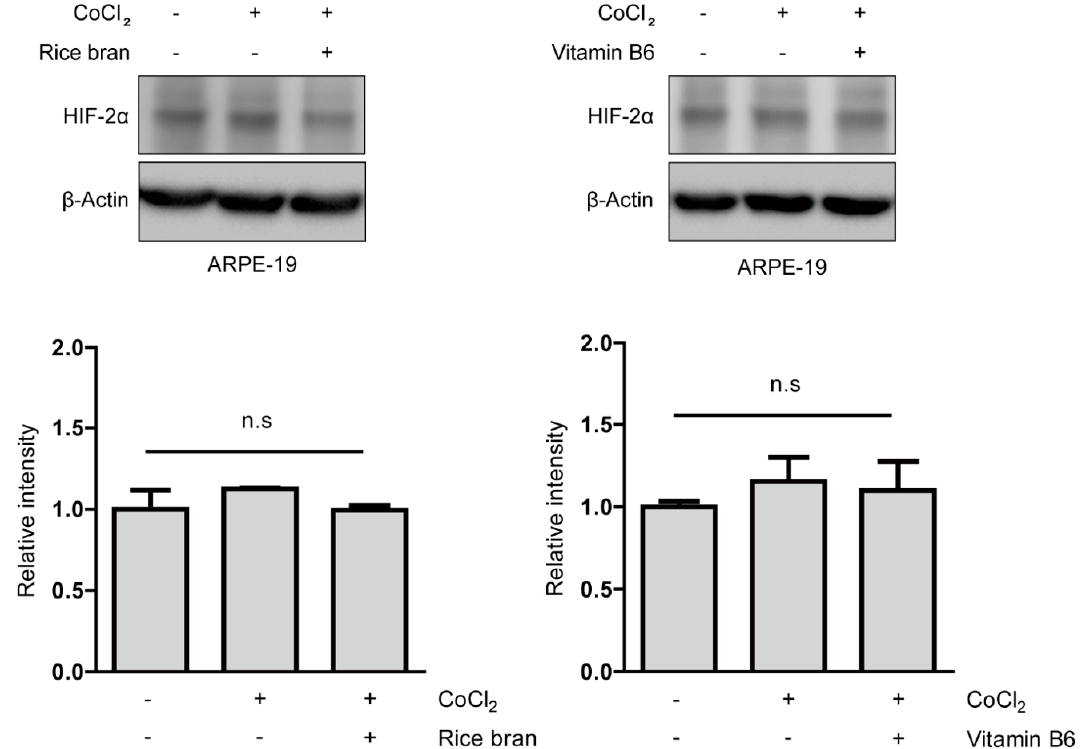
Figure A5. No effect of rice bran and vitamin B6 on HIF ‐ 2 α stabilization. Representative immunoblot images and quantitative analyses (n = 4 per group) for HIF ‐ 2 α and β‐ Actin showed that HIF ‐ 2 α was not significantly stabilized in ARPE ‐ 19 cells under a CoCl 2 ‐ induced pseudo ‐ hypoxic condition. 1 mg/mL of rice bran and vitamin B6 did not significantly change its expression. Bar graphs were presented as mean ± standard deviation. The data were analyzed using one ‐ way ANOVA followed by a Bonferroni post hoc test. Solvents, rice bran: DMSO; vitamin B6: water.